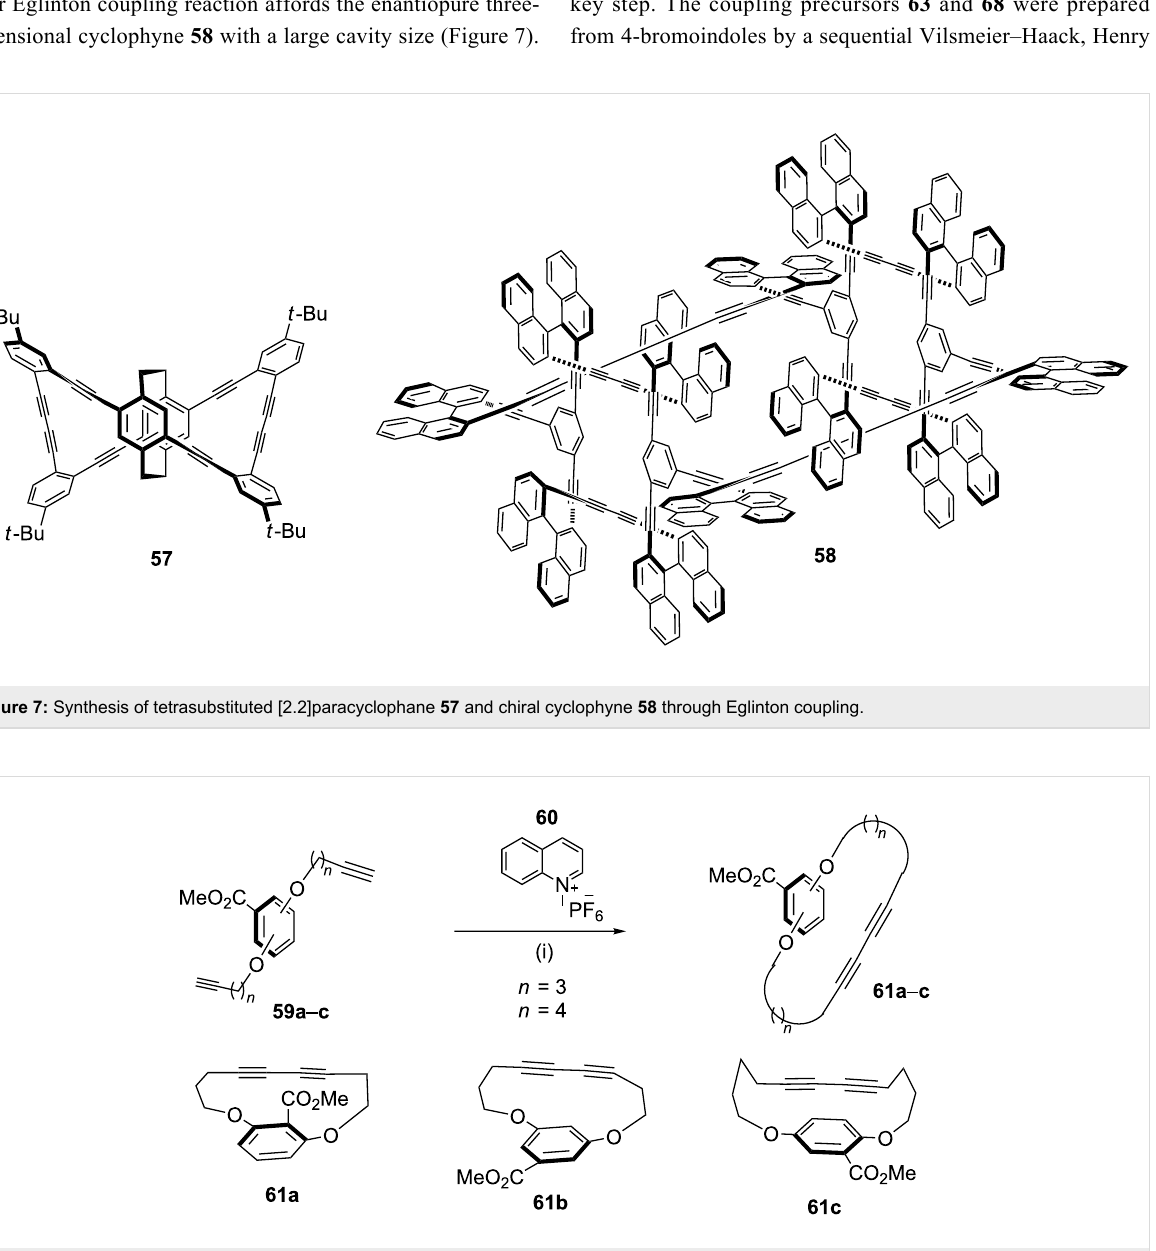
Scheme 9: Synthesis of cyclophane through Glaser–Hay coupling reaction. Reagents and conditions: (i) CuCl 2 (12 equiv), TMEDA (12 equiv), O 2 , PhMe, 18 h, 80